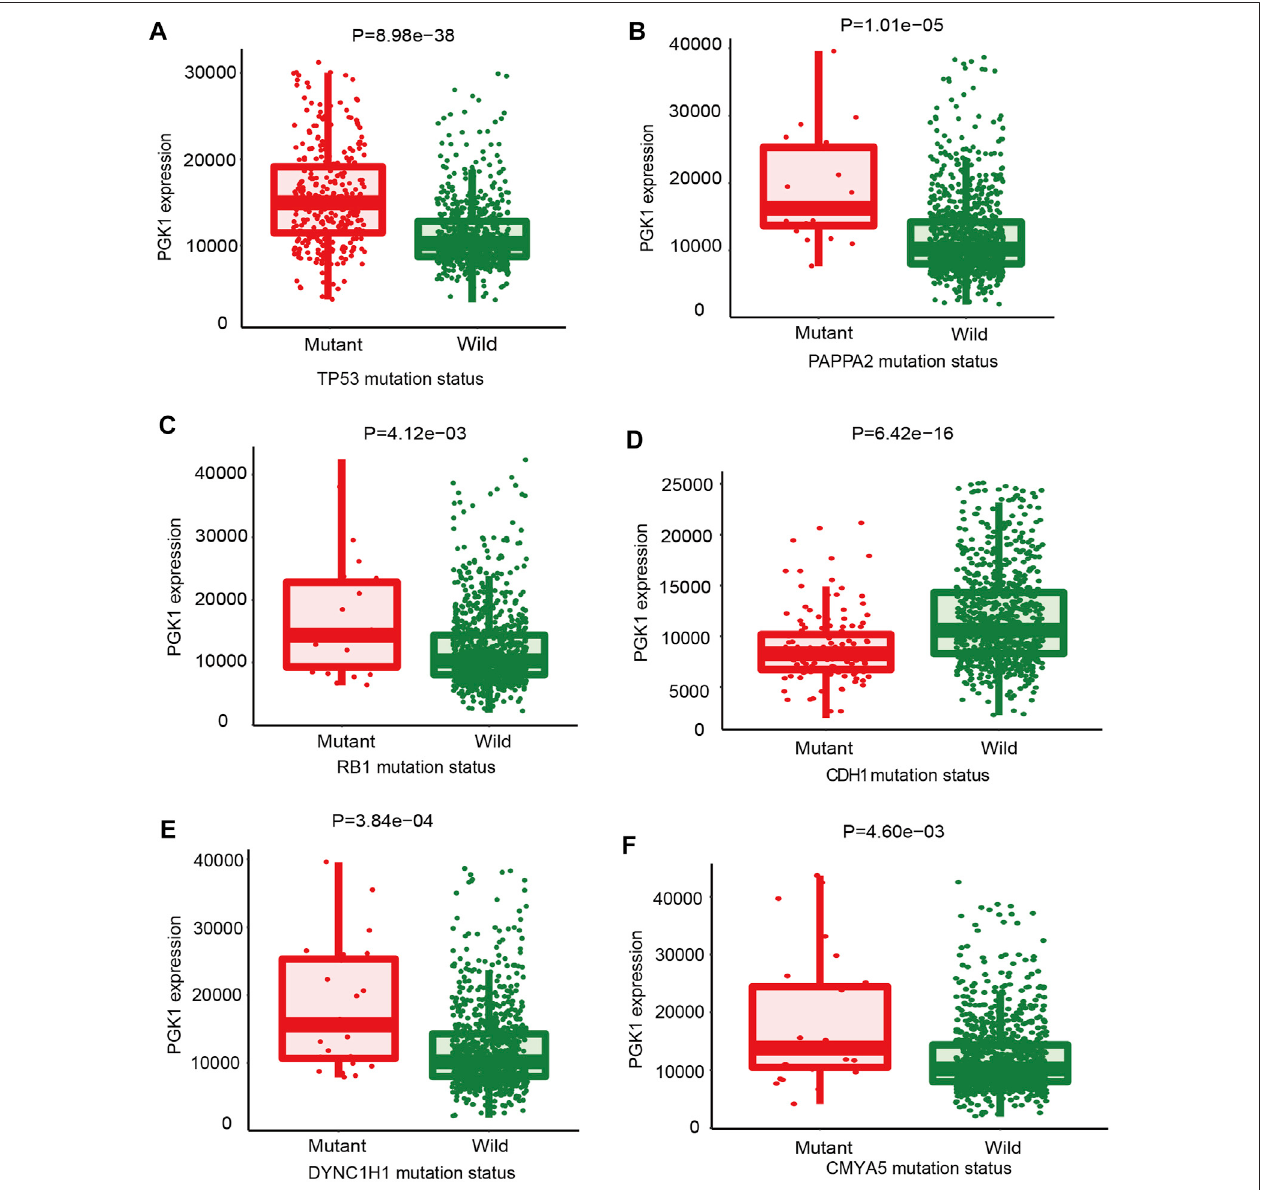
FIGURE 6 | The mutations that correlated with PGK1 gene expression in breast cancer were identi fi ed. The oncogenes or tumor suppressor genes mutations correlatedwithPGK1expressionwasanalyzedbyTARGETfrommuTargetplatform.ThesixgeneswhosemutationsaremoststronglycorrelatedwithPGK1expression changes in breast cancer. TP53, tumor protein p53 (A) ; PAPPA2, pappalysin 2 (B) ; RB1, RB transcriptional co-repressor 1 (C) ; CDH1, cadherin 1 (D) ; dynein cytoplasmic1heavychain1 (E) ;CMYA5,cardiomyopathyassociated5 (F) .Screeningofsigni fi cantgeneswerebasedontheMann-Whitney p valueandmeanFC of the test, p ≤ 0.01 and 0.714 > FC > 1.4 and a prevalence of at least 1%.